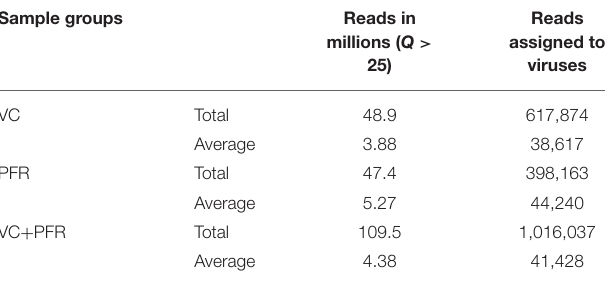
TABLE 1 | Reads assigned to viruses in the vitreous fluid of control (VC) and post-fever retinitis (PFR) groups. Sample